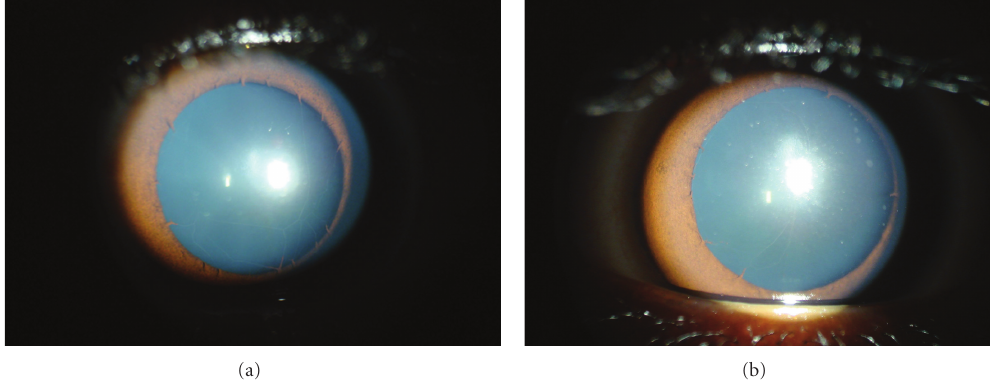
Figure 1: (a) Clinical photograph of the right eye with complete absence of the iris sphincter, persistent pupillary membrane stretching across a large pupil in undilated state. (b) Clinical photograph of the left eye with rudimentary strands arising from the iris margin and a large pupil in undilated